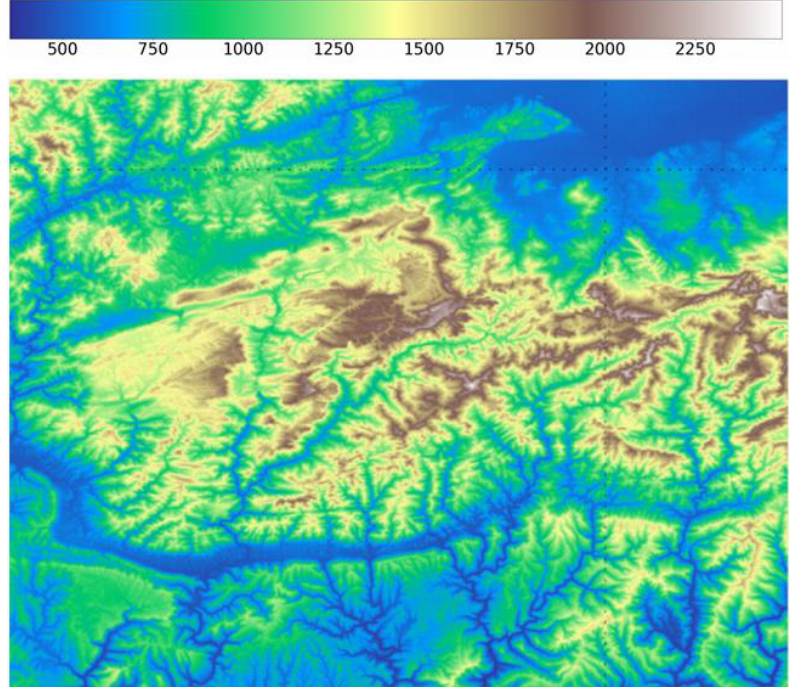
Figure 47. DTM for JORDANA site and Level-1 processing, produced by VIQ. Reference Image Management